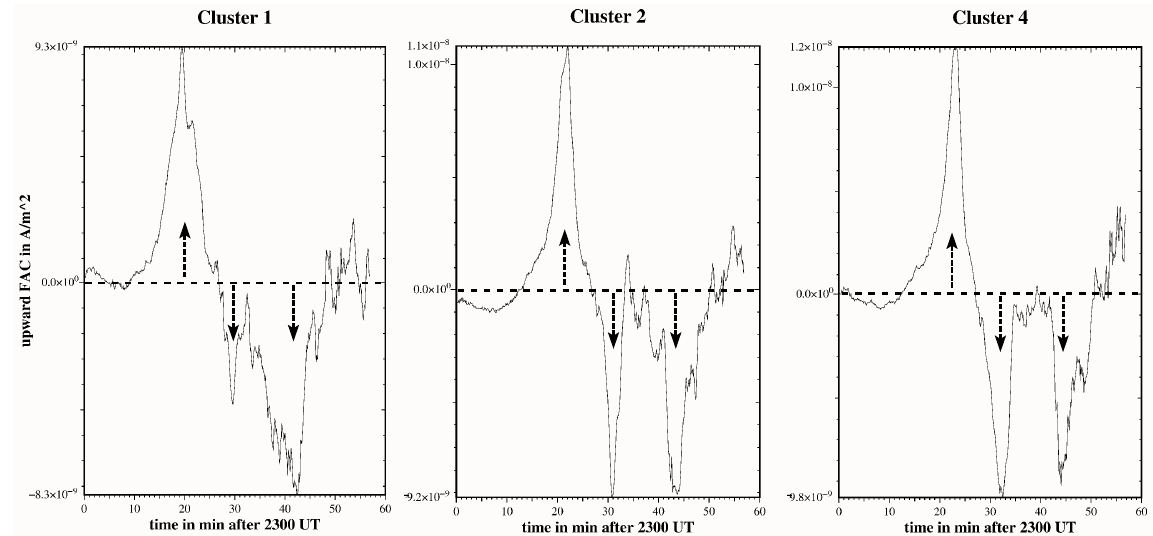
Fig. 7. FAC as calculated from the Cluster II spacecraft 1, 2 and 4, at the spacecraft altitude, using the assumption of infinite current sheets (in Am − 2 , positive values correspond to upward FAC).